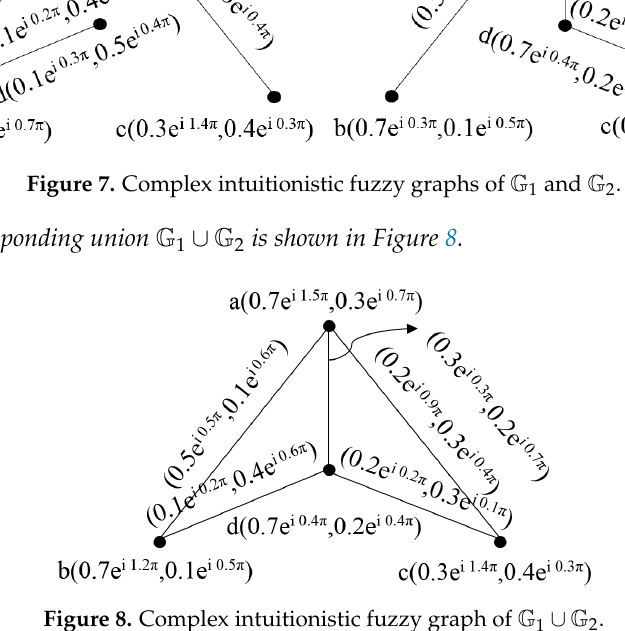
Figure 8. Complex intuitionistic fuzzy graph of G 1 ∪ G 2